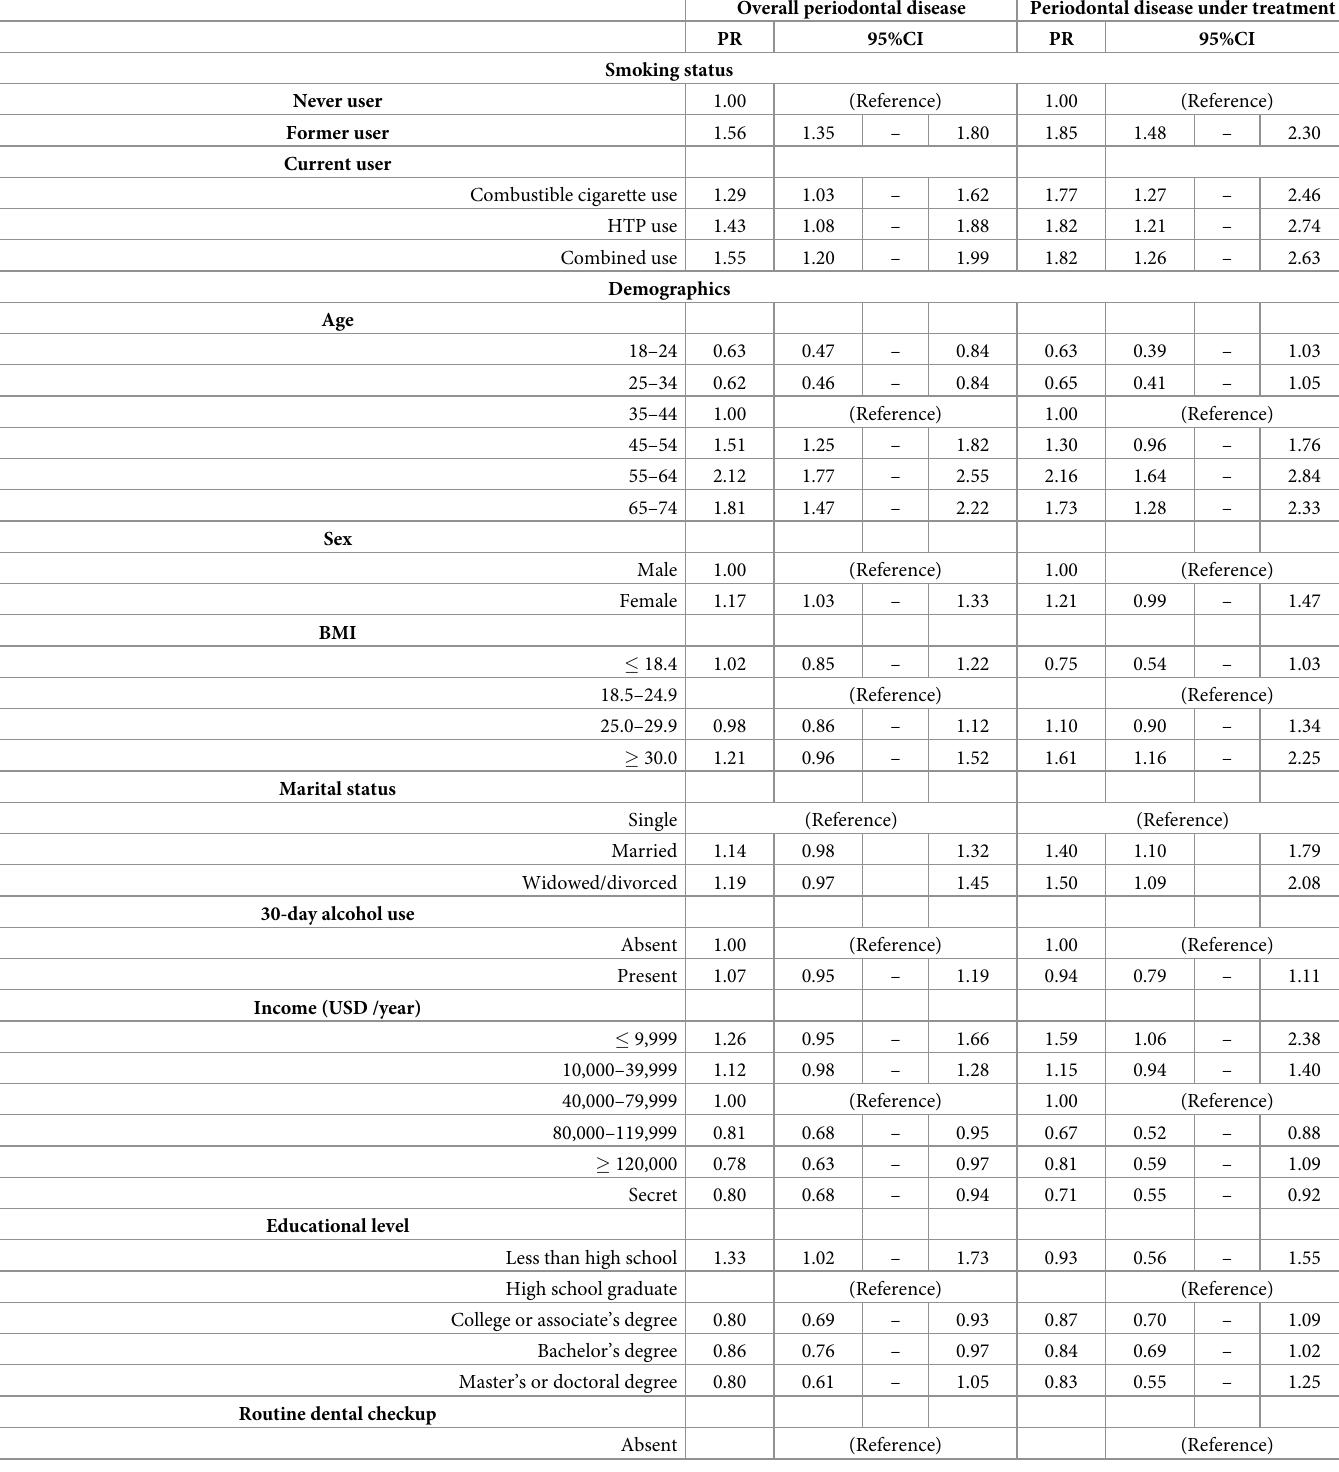
Table 2. Results of multivariable modified Poisson regression analysis to estimate the prevalence ratios for overall periodontal disease and periodontal disease under